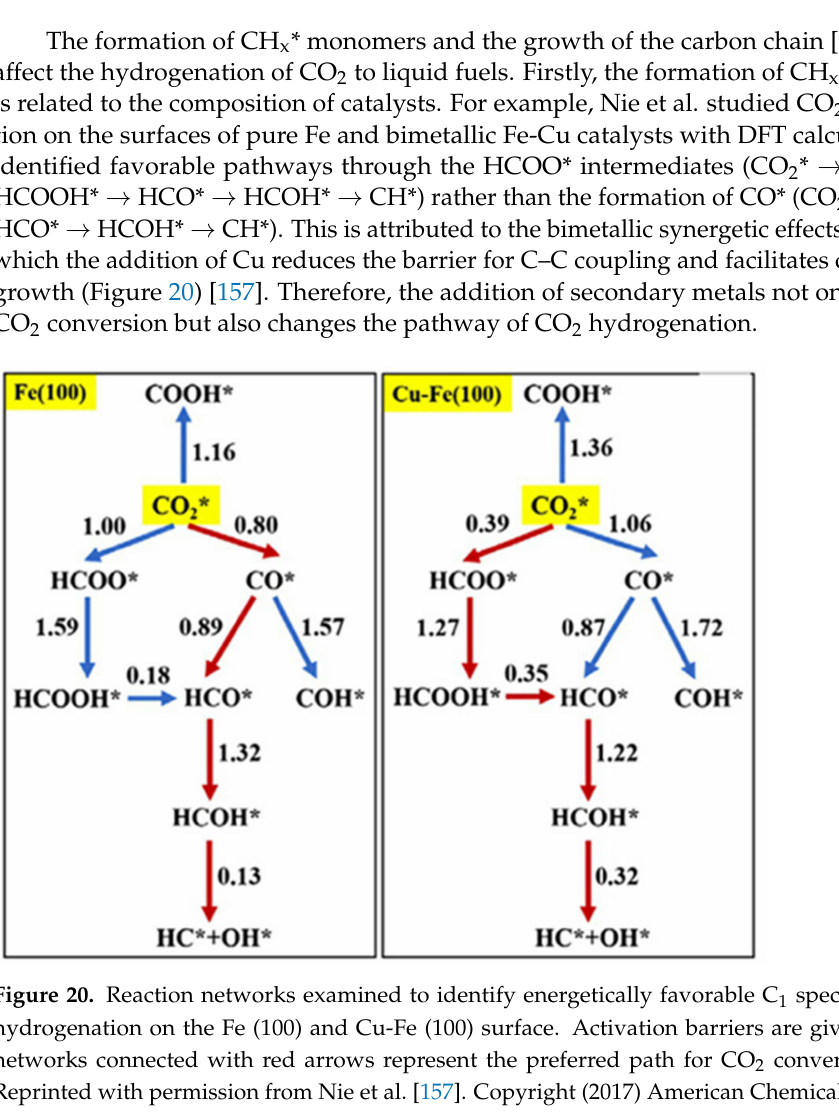
Figure 19. Scheme of CO 2 -modified FTS-based catalytic mechanism. Reprinted with permission from Ye et al. [155]. Copyright (2019) Springer Nature.